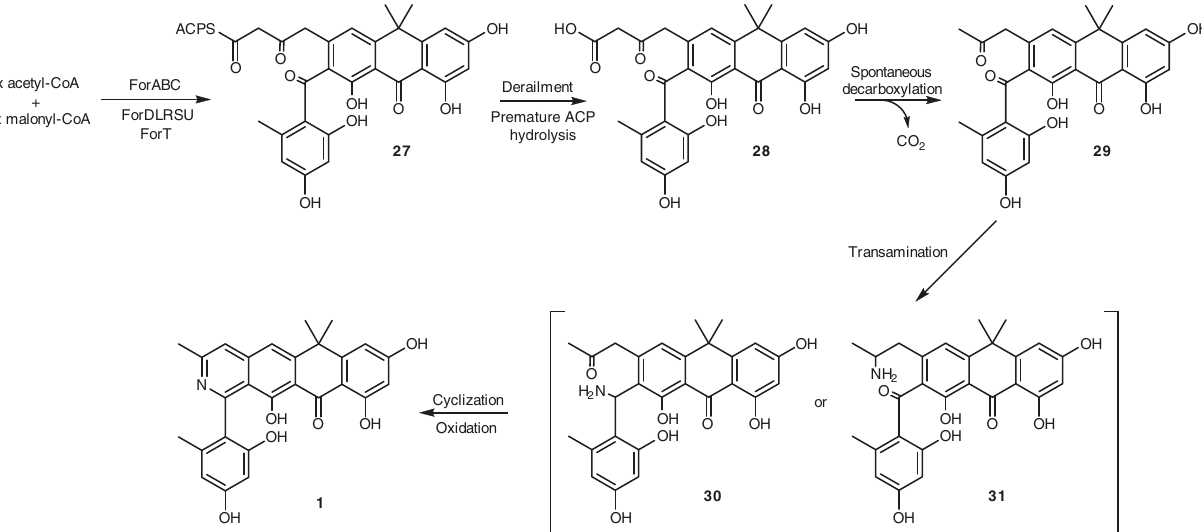
Fig. 4 Proposed biosynthesis of the formicapyridine backbone. Derailment of fasamycin biosynthesis due to premature hydrolysis of the PKS acylcarrier protein leads to the β -ketoacid intermediate 28 which is facile to decarboxylation yielding methylketone 29 . Transamination of 29 leads of amine intermediates which can undergo spontaneous cyclization and aromatization to yield